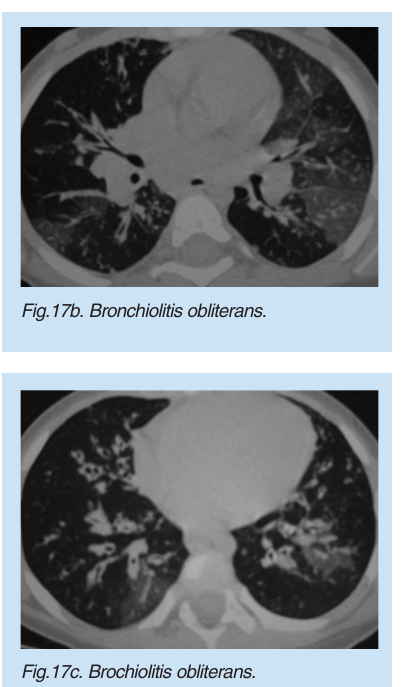
Fig. 20b. Noonan’s